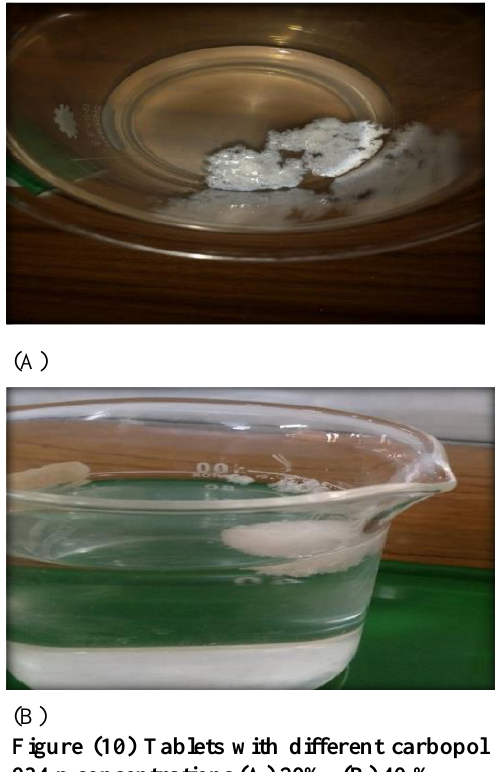
Figure (10) Tablets with different carbopol 934 p concentrations (A) 20%, (B) 40 %. Effect of carbopol 934 p concentration on in vitro drug release The effect carbopol 934p